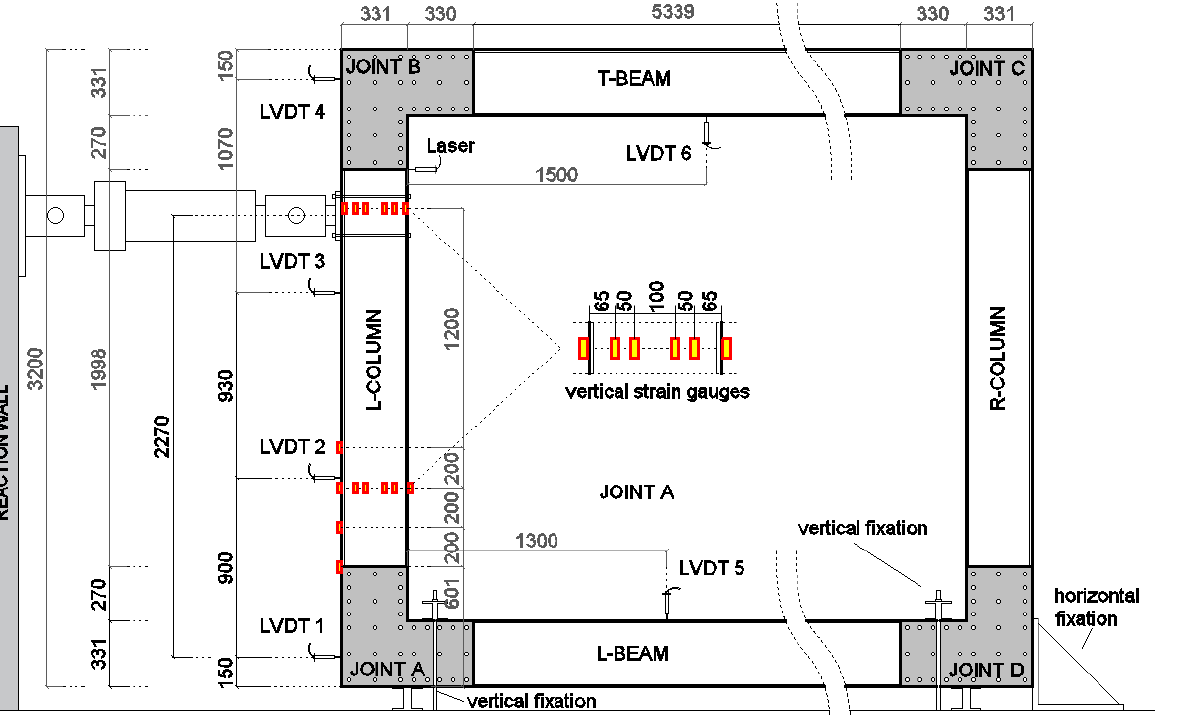
Figure 7. Close ‐ up of a portal frame joint: ( a ) external side; ( b ) inner side. The load was applied at a height equal to 2.27 m with respect to the centre of the lower joints, corresponding to 70% of the column length. The test was carried out in displacement control with a stroke rate of 2.2 mm/s. Along the L ‐ column, at different heights, LVDT were placed (LVDT 1, LVDT 2, LVDT 3, LVDT 4) to record the horizontal displacement distribution of the member during the test. In addition, a laser sensor was placed to record the horizontal displacement of the column in proximity to the load application point. Strain gauges sensors were applied over the